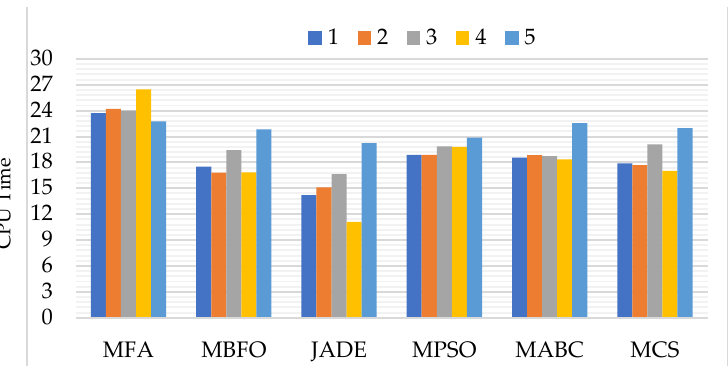
Table 8. MSE and PSNR using different optimization algorithms with the GLCM method.